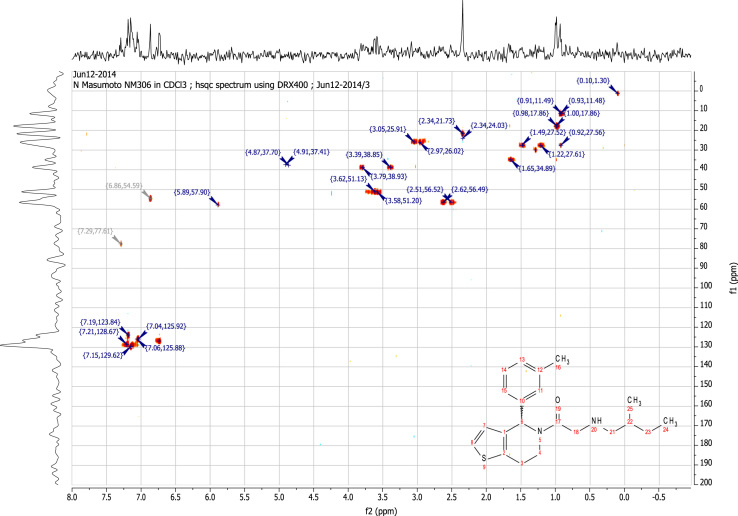
2D HSQC (400 MHz,
CDCl3) of RU-SKI 101
(9c).